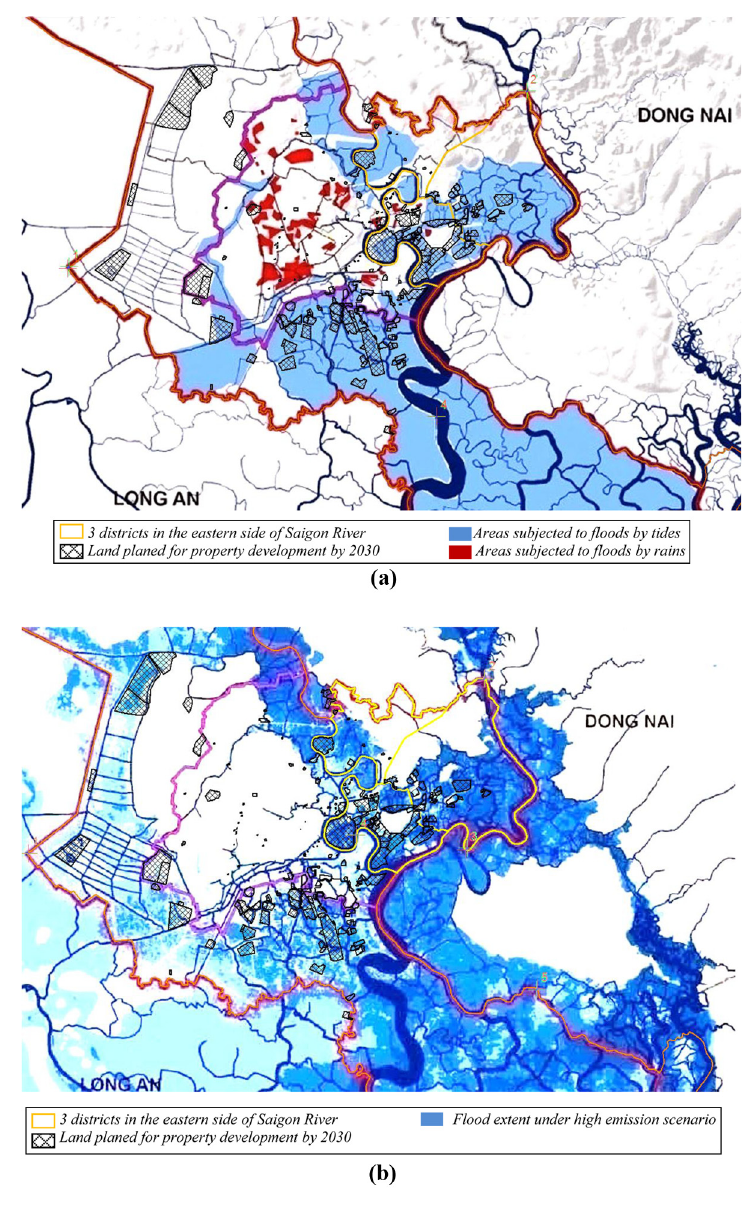
Figure 5. Property developments exposed to fl